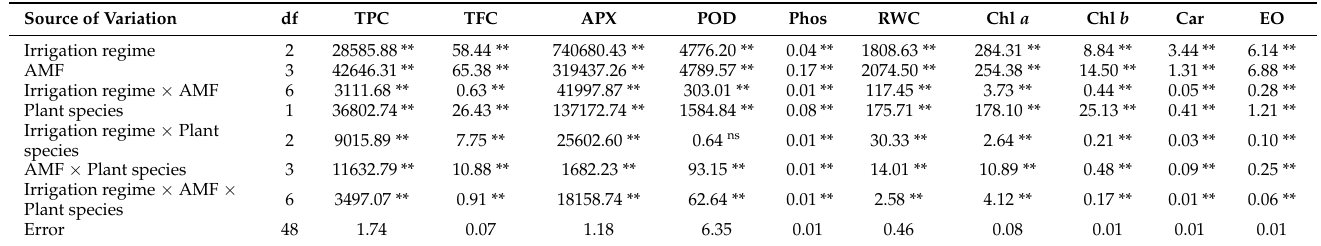
Table 2. Effect of plant species, AMF inoculation, and water treatments on all biochemical parameters in Perovskia